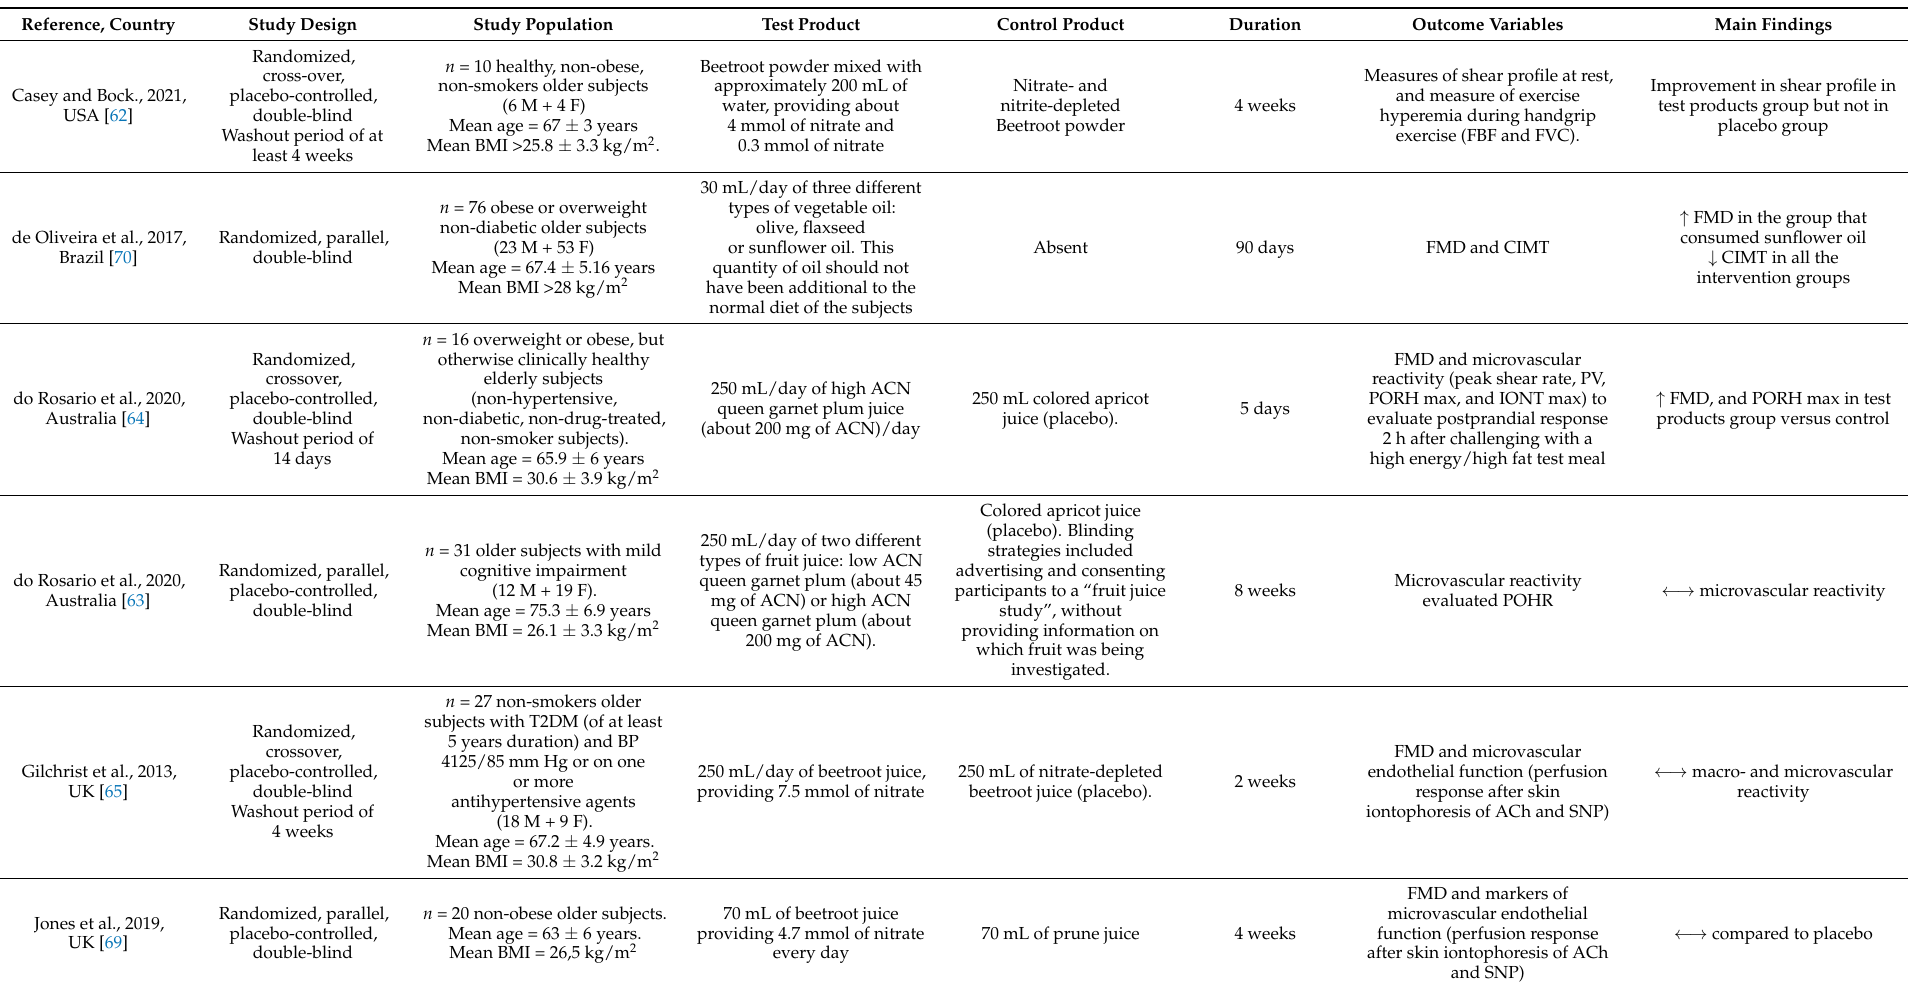
Table 2. Characteristics of the chronic intervention studies investigating the effects of plant-food consumption on markers of vascular function in older